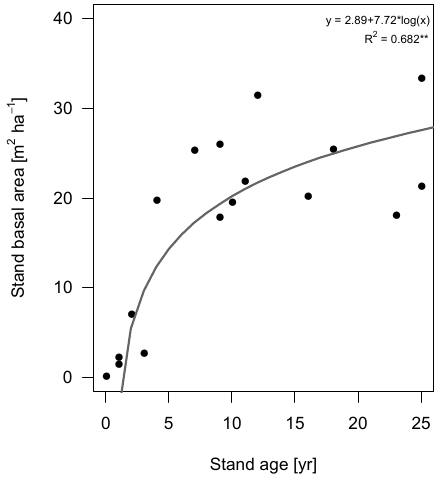
Figure S1. Changes in stand basal area over successional age.